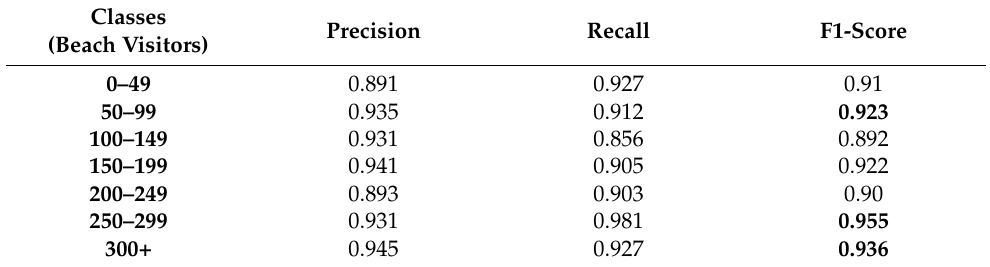
Table 8. Per-class precision, recall, and F1-scores for the time period 2018–2020.